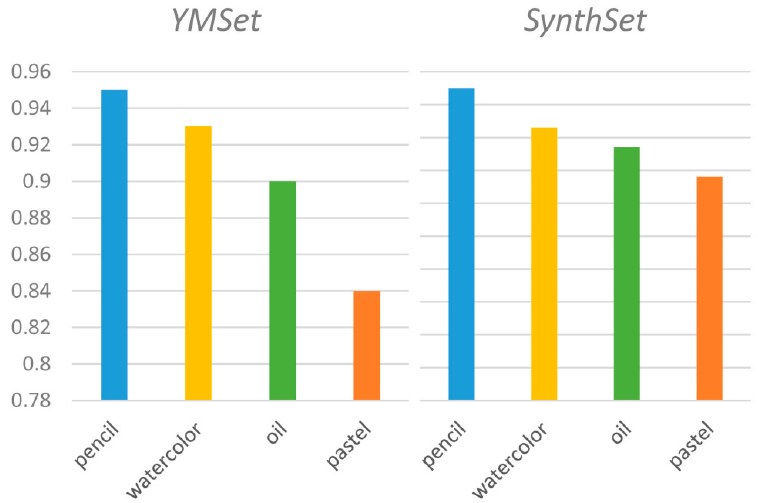
Figure 11. The decreasing order of recall values of the confusion matrices in Figure 8 for YMSets and SynthSet .